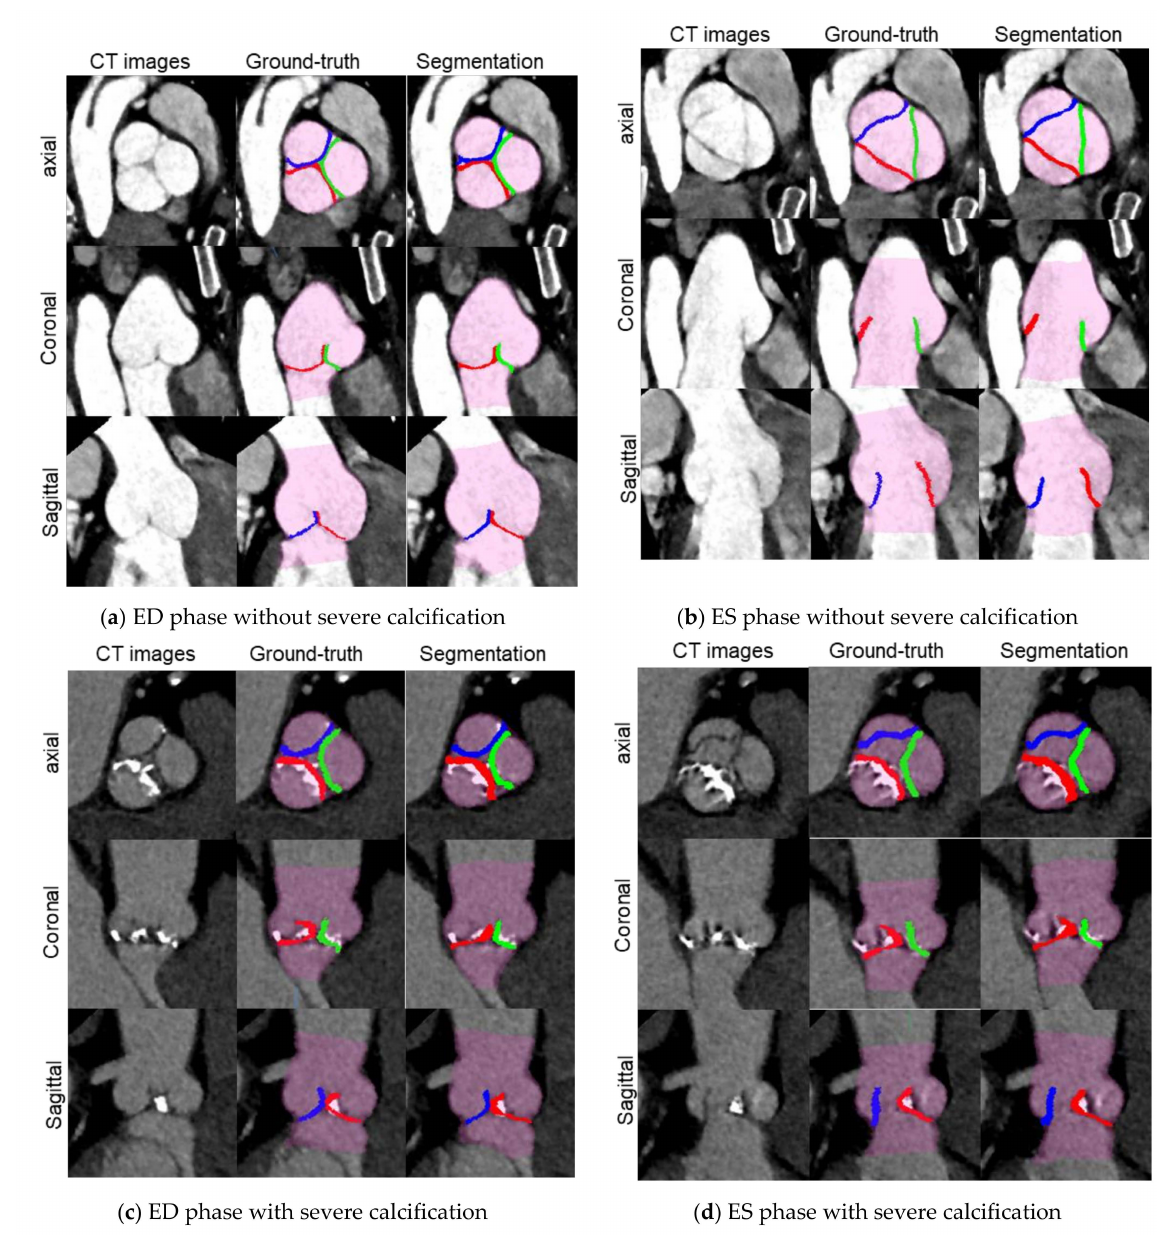
Figure 5. Visualization of CT images (WW/WL: 650/300) only, overlaid with each ground-truth label and overlaid with each segmentation result in the test step for 2 cases: ( a , b ) a case without calcification; ( c , d ) a case with severe calcification. Translucent purple: aortic root labels, Green: RCC labels, Blue: LCC labels and Red: NCC